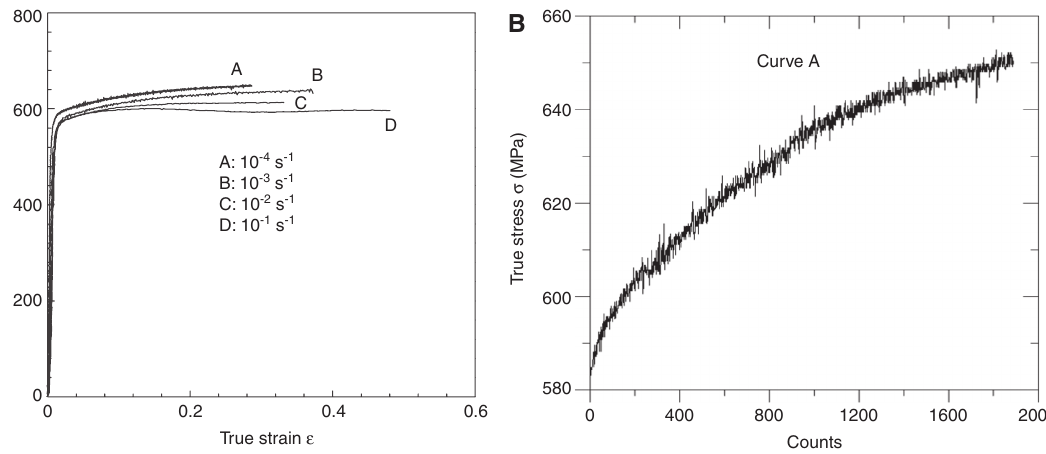
Figure 1: (A) Compressive true stress-strain curves [19] for an as-extruded Al-Mg alloy at room temperature at different strain rates. (B) Serrations of the true stress-strain curve (curve A) shown in Figure